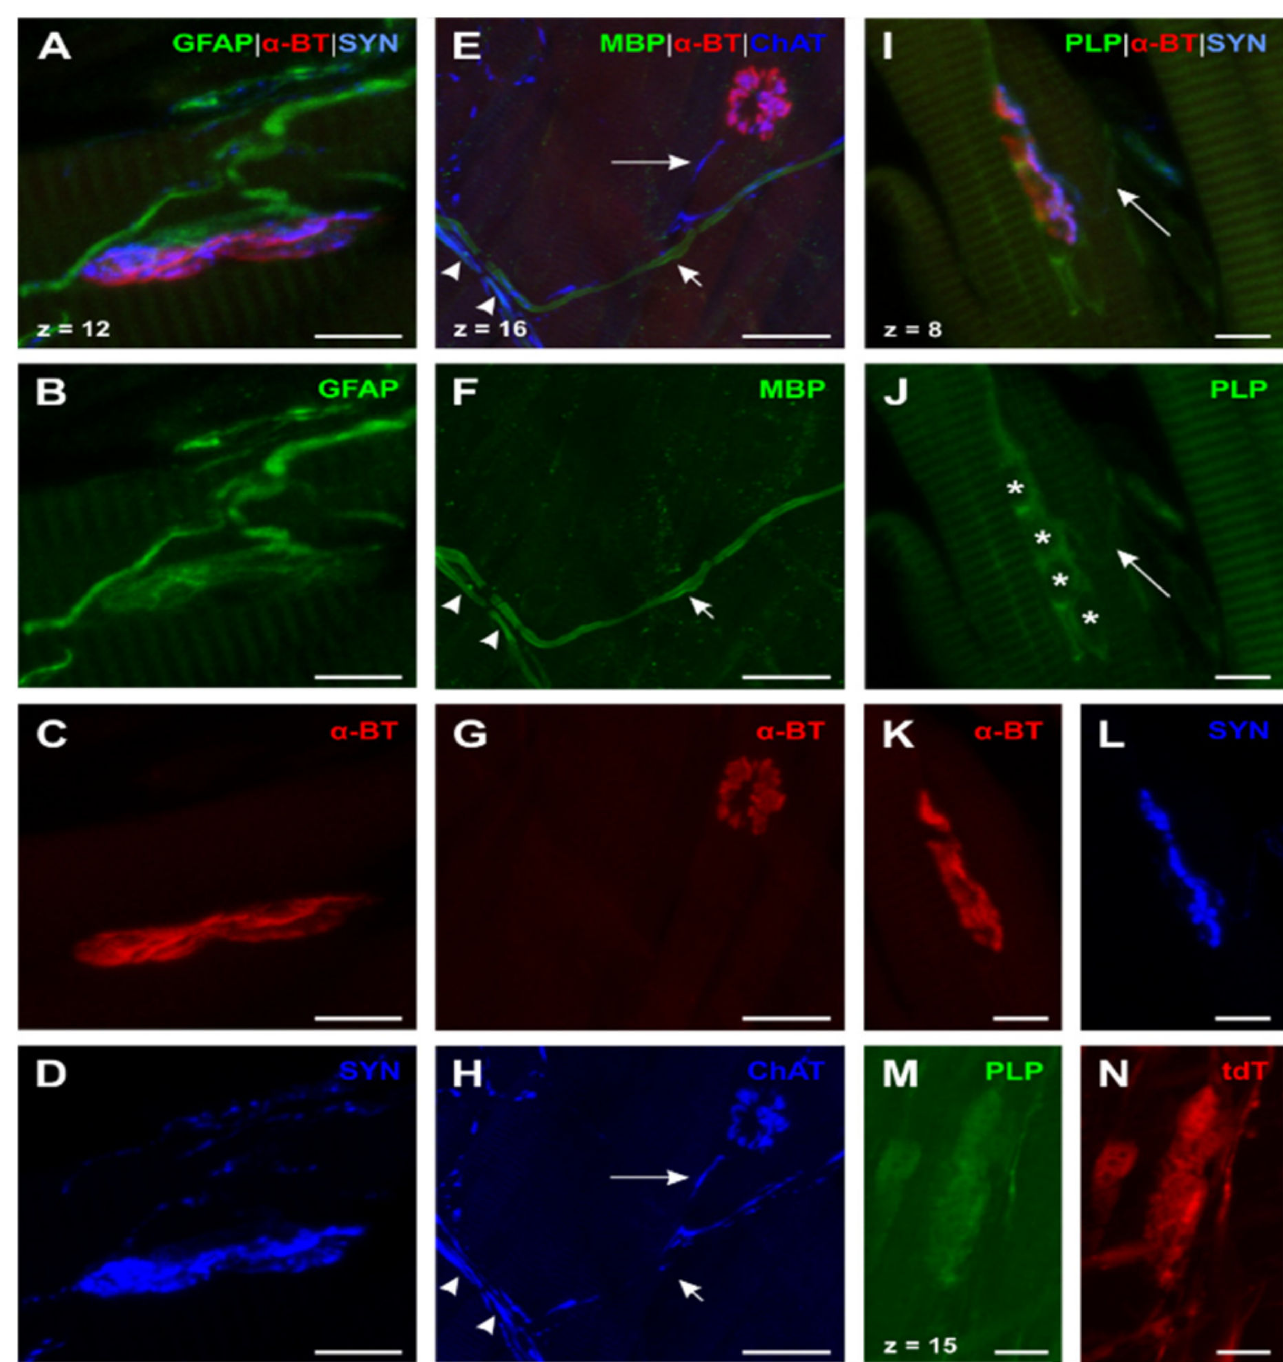
Figure 2. Expression of GFAP, MBP, and PLP in neuromuscular junction (NMJ) of the esophagus ( A )–( D ): Triple staining for GFAP, α -bungarotoxin ( α -BT), and synaptophysin (SYN) (N ◦ 3 (cid:13) , Table 1) showed a similar distribution as the skeletal muscle with the exception that efferences were unmyelinated and had a smaller caliber. ( E )–( H ): Quadruple staining for MBP, α -BT, cholin acetyltransferase (ChAT), and Hoechst (Hoechst not shown; N ◦ 1 (cid:13) , Table 2). ChAT + -efferences which contact the motor endplate always lack myelin (( E ) and ( H ), long arrow). Two further types of fibers could be detected: (1) Myelinated ChAT + -efferences (( E ) and ( F ), arrowheads) and (2) myelinated ChAT − -fibers (( E ) and ( F ), short arrow)—the latter can be brought in line with esophageal afferences. ( I ) and ( L ): Quadruple staining for PLP, α -BT, SYN, and Hoechst (Hoechst rnot shown; N ◦ 5 (cid:13) ; Table 1). In contrast to the skeletal muscle, PLP was present in all investigated NMJs as grouped PLP + -glial cells around the endplate indicate ( I ) and ( J ). Nuclei of these PLP + -PSCs are marked by asterisks ( J